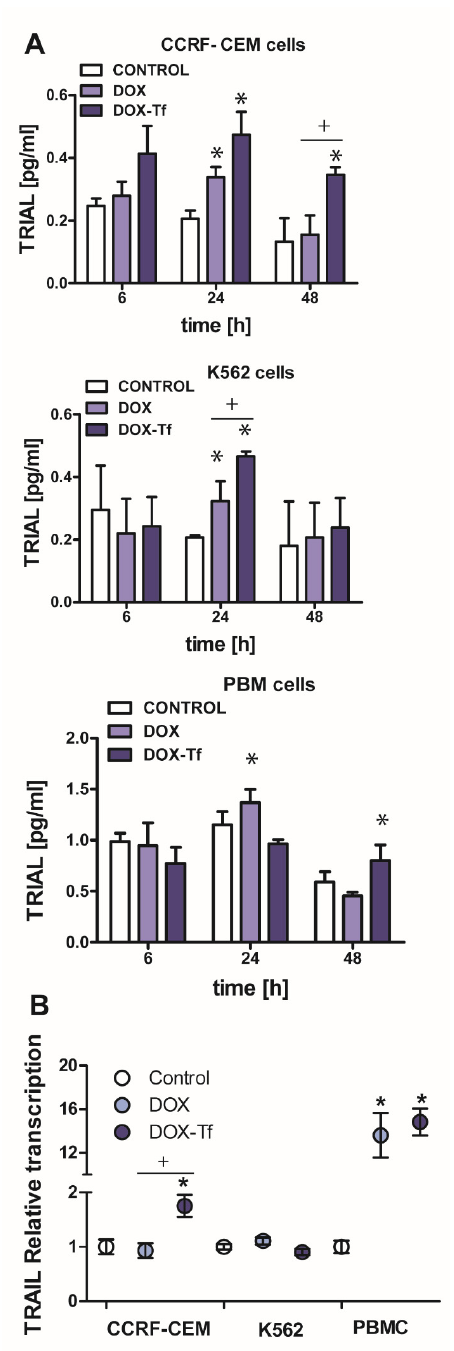
Figure 4. Doxorubicin -transferrin conjugate alters TRAIL ligand expression in human leukemia cells. ( A ) The production of TRAIL-ligand (TRAIL-L) in cancer and normal cells incubated with IC 50 concentrations of doxorubicin (DOX) and doxorubicin–transferrin (DOX–Tf) conjugate for 6, 24, or 48 h. The results represent mean ± SD of three independent experiments. * p < 0.05 in comparison to respective control cells taken as 100%, ( + ) statistically significant di ff erence observed between cells incubated with DOX in comparison to DOX–Tf, + p < 0.05. ( B ) TRAIL-L transcript levels (relative to Hydroxymethylbilane synthase (HPRT1) and hydroxymethylbilane synthase (HMBS) housekeeping genes) in CCRF-CEM and K562 cell lines and PBMCs exposed to either form of DOX for 24 h at IC 50 concentrations, n = 3. Asterisks refer to significant di ff erences (* p < 0.05) in the transcription levels in cells treated with free drug or DOX–Tf compared to the untreated cells. + indicates statistically significant changes between samples incubated with DOX alone or with DOX–Tf ( + p <